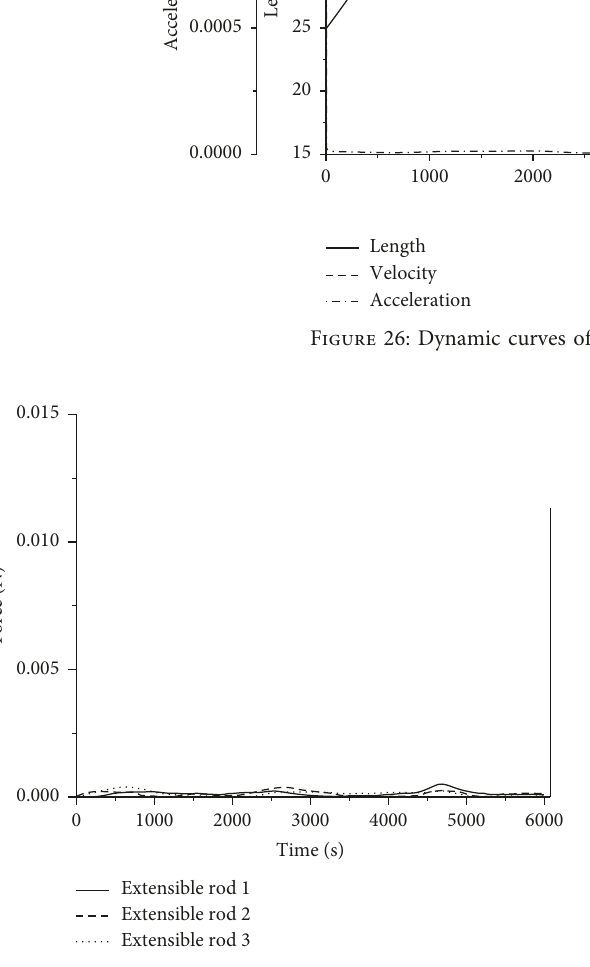
Figure 27: Driving forces of the three extensible rods with time.